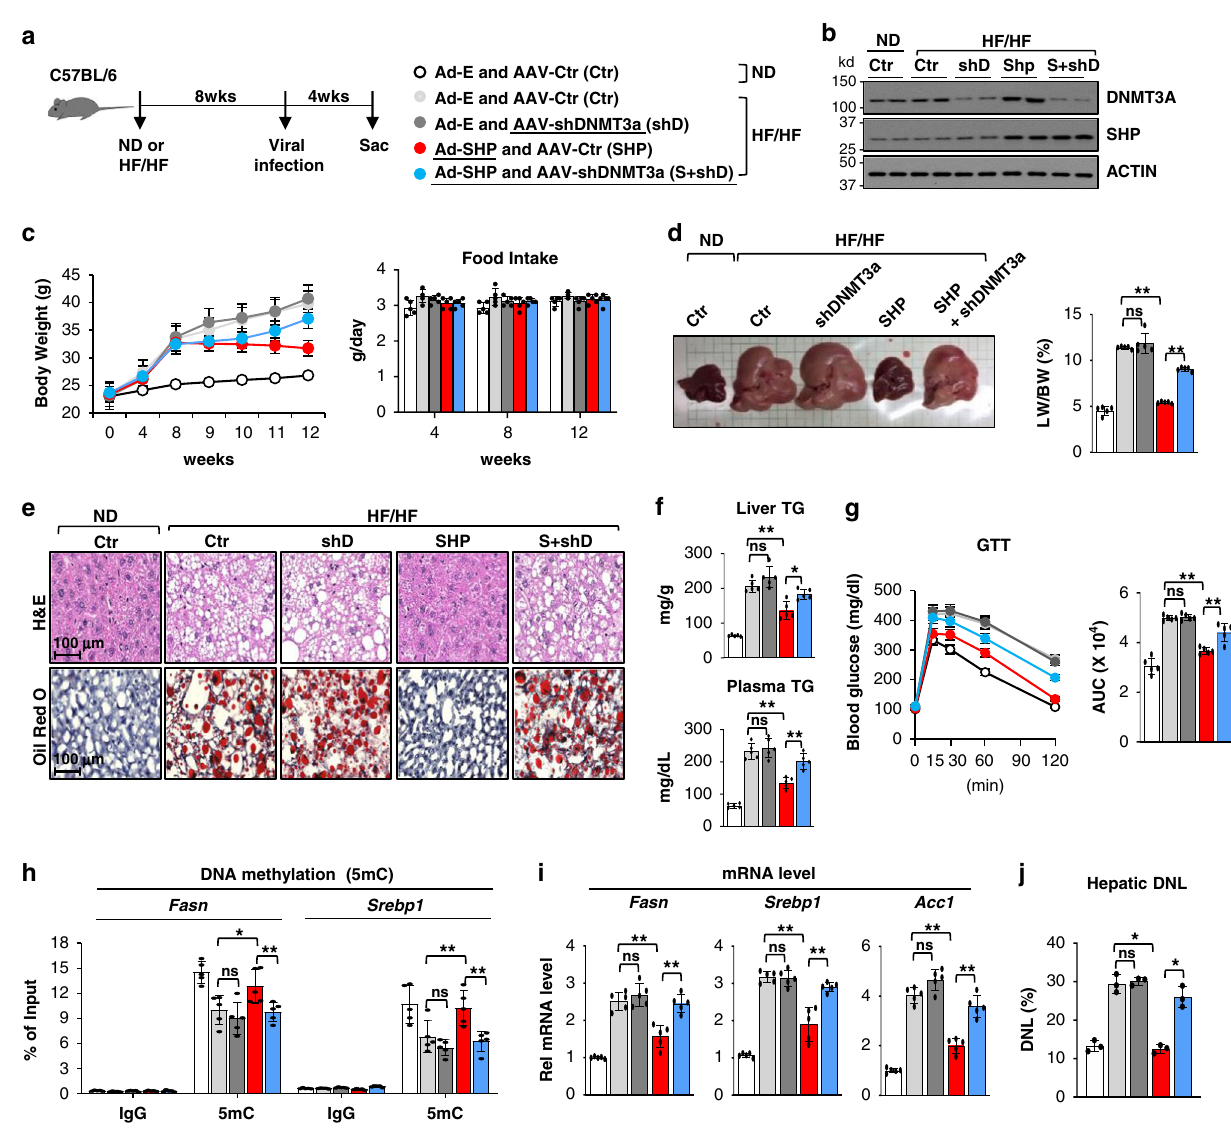
Fig. 7 SHP-mediated repression of lipogenesis and amelioration of fatty liver in obese mice are diminished by liver-speci fi c downregulation of DNMT3A. C57BL/6 mice were fed normal chow diet (ND) or a high-fat /high-fructose (HF/HF) diet for 8 weeks, then infected with the combinations indicated in ( a ) of AAV-empty (Ctr), AAV-shDNMT3A, Ad-SHP, and Ad-empty (Ctr) and sacri fi ced 4 weeks later. a Experimental outline. b Levels of DNMT3A and SHP protein in the liver determined by IB. Shown are results for two mice and IB analysis was done twice. c Changes in body weight (left) and food intake (right). d Representative images of livers tissues (left) and the ratio of liver/body weight (right, n = 5). e Liver sections stained with H&E (upper panels) and Oil Red O (lower panels). Representative images are shown for one mouse in each group. Similar results were observed in two additional mice in each group. f Liver (upper) and plasma (lower) TG levels. g Glucose tolerance test (GTT) with calculated areas under the curve (AUC) plotted (right). h DNA methylation at Fasn and Srebp1 promoter regions measured by MeDIP. i Levels of mRNAs of the indicated lipogenic genes determined by RT-qPCR. j Mice were given 4% deuterated drinking water for 2 days and DNL was measured as described in methods. c , d , f – j The mean values ± SD are plotted ( c , d , f – i , n = 5 mice; j , n = 3 mice). Statistical signi fi cance was determined by ( d , f , g , i , j ) one-way ANOVA or ( h ) two-way ANOVA with the Tukey post-test. * P < 0.05, ** P < 0.01, ns, statistically not signi fi